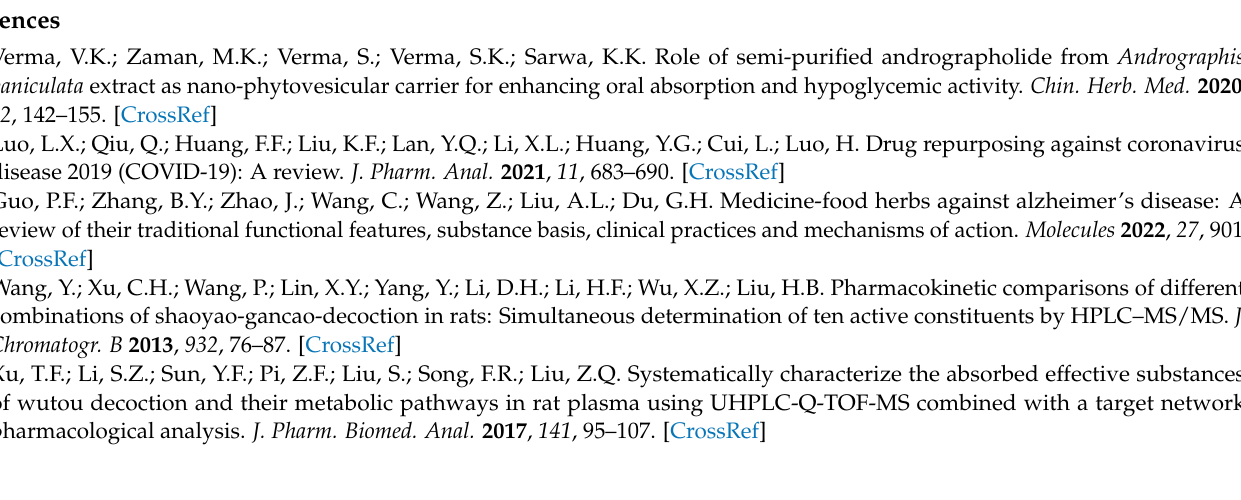
Figure S4. Optimization of the mass-dependent ramp collision energy (MDRCE) for the DDA approach in both negative (NEG) and positive (POS) modes using the representative compounds from WXG. Figure S5. Drift time VS m / z showing the separation of isomers and drift time VS t R showing the separation of co-eluting components from WXG. Figure S6. Annotation of the CID-MS 2 spectra of the representative protopanaxadiol (PPD) and protopanaxatriol (PPT) ginsenosides from WXG using UNIFI TM , identified by comparison with the reference compounds. Figure S7. Comparison of different extraction solvents for 27 analytes. Figure S8. Representative sMRM chromatograms demonstrating the specificity of the established multicomponent quantitative assay approach: (A) the blank sample (methanol); (B) methanol spiked with the reference compounds and the internal stan- dard; (C) the real sample of WXG. Table S1. Information for 71 reference compounds used in this work. Table S2. Detailed information for the WXG samples analyzed in the current work. Table S3. Detailed information for 20 candidate columns used in stationary-phase screening. Table S4. Detailed information for the 205 components characterized from the WXG. Table S5. Calibration curves, linearity, LOQ, LOQ, intra-day and inter-day precision, stability, repeatability, recovery, and matrix effects for the UHPLC-sMRM approach quantifying 24 analytes of WXG. Table S6. The contents of 24 analytes in 27 batches of WXG samples